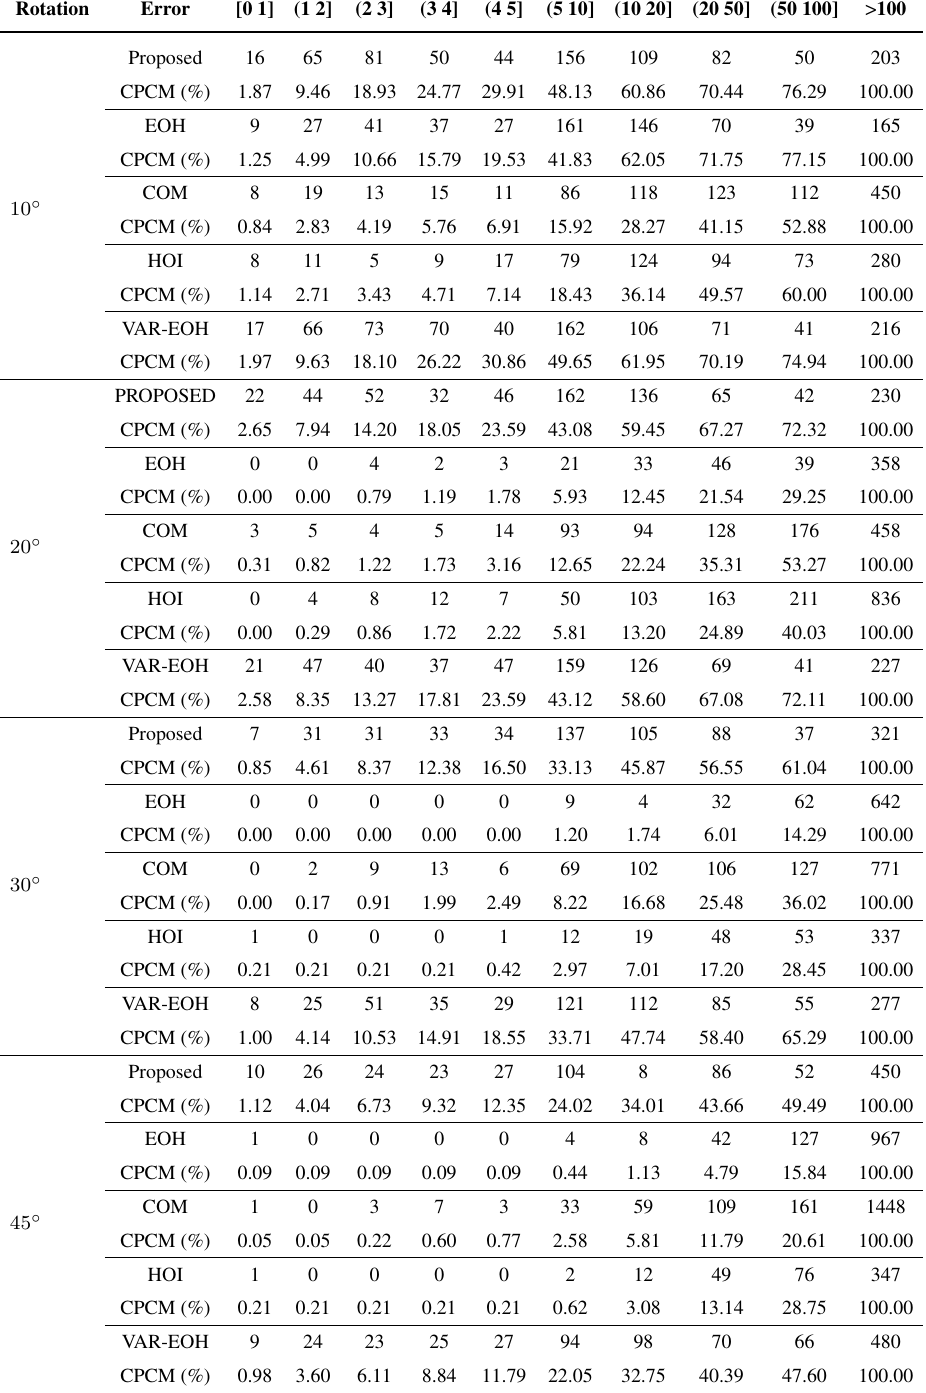
Table 2. Comparison of keypoint matches for different methods on dataset VS-LWIR. The cumulative percent of correct matches (CPCM) is